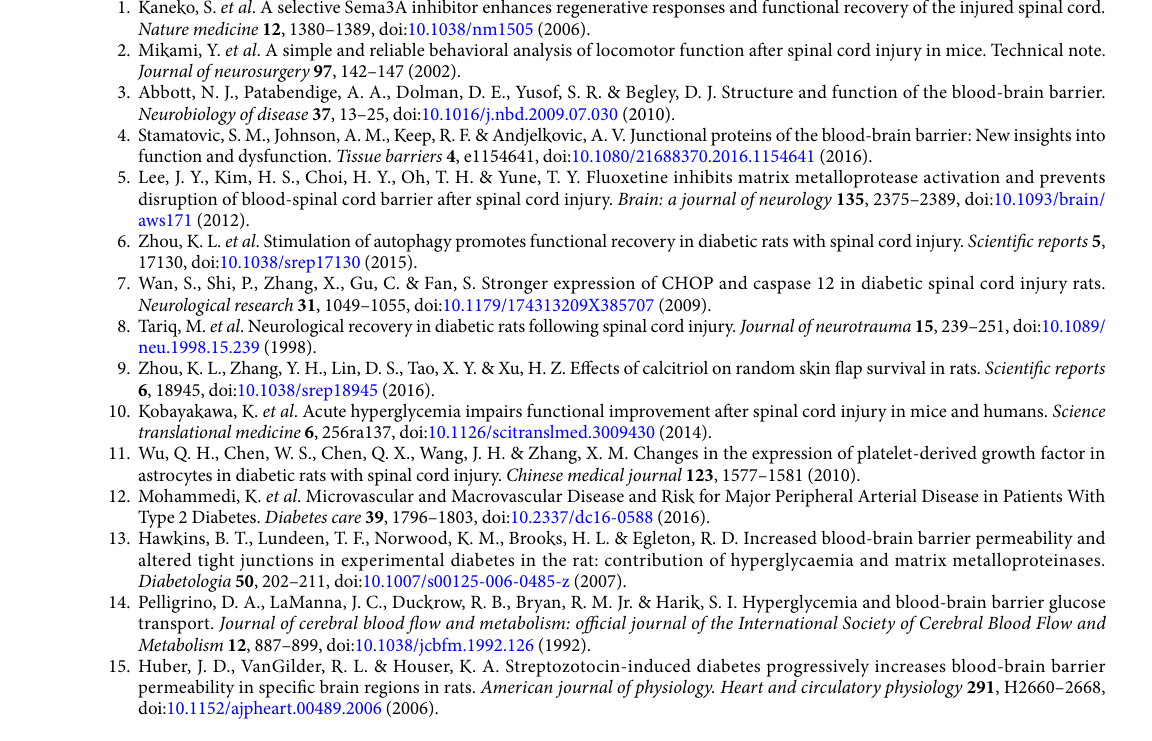
is 20 mg/mL) for 12 h. H 2 O 2 (100 μ mol/L, Sigma) was used to mimic the SCI environment. To further assess the effects of inhibiting ER stress activation on HG-induced injury, cells were treated with 4-PBA (1 mM) for 2 h